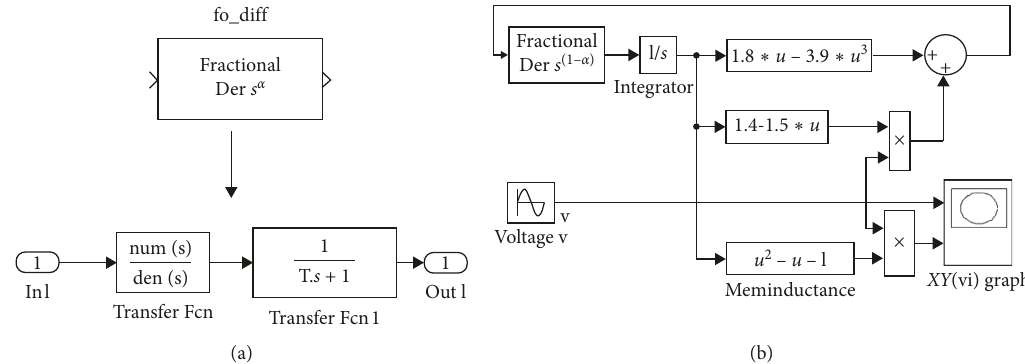
Figure 6: Block diagrams in Simulink of MATLAB. (a) Differentiator block design4 of the order α ; (b) block diagram of the fractional-order memristor.